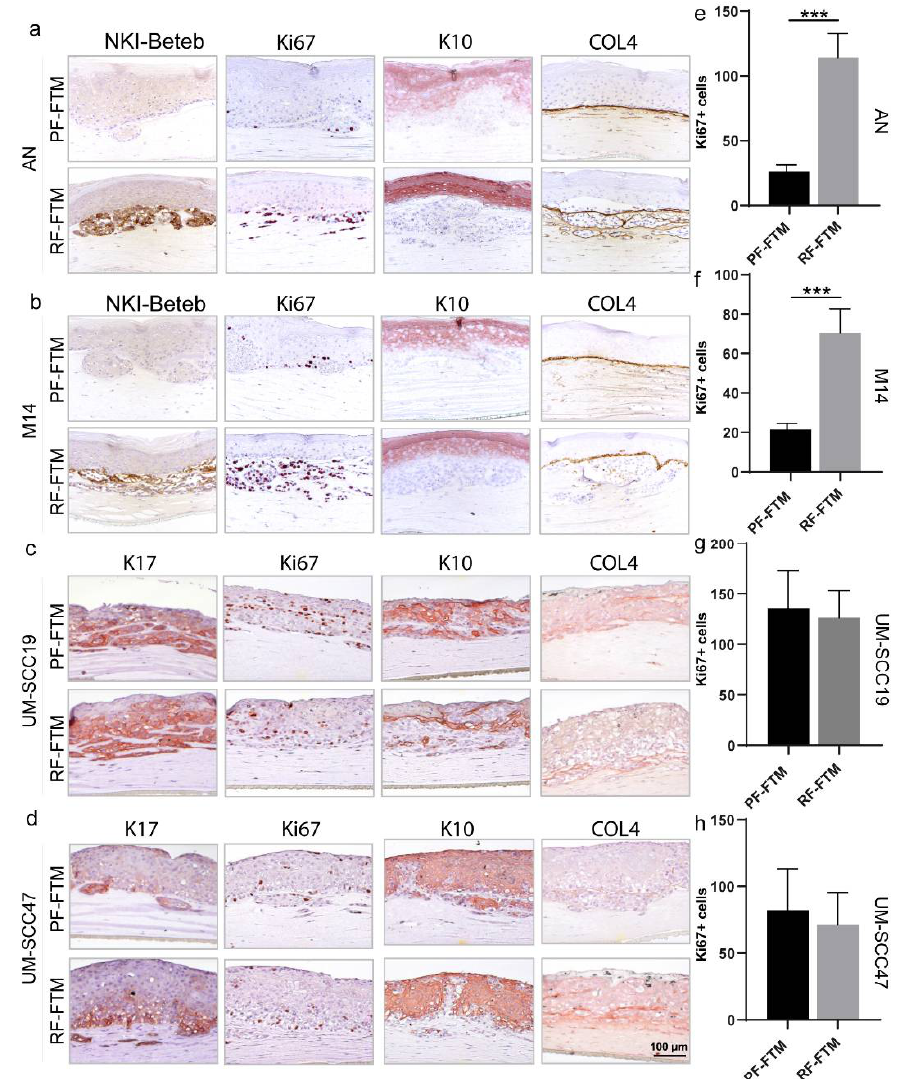
Figure 3. Effect of fibroblast subpopulations on melanoma and HNSCC morphogenesis. By IHC staining, the expression of NKI/Beteb, Ki67, K10 and COL4 were detected in ( a ) AN-FTMs and ( b ) M14-FTMs. The expression of K17, Ki67, K10 and COL4 was detected in ( c ) UM-SCC19-FTMs and ( d ) UM-SCC47-FTMs. The number of absolute Ki67-positive cells in ( e ) AN-FTMs, ( f ) M14-FTMs, ( g ) UM-SCC19-FTMs, and ( h ) UM-SCC47-FTMs was counted. Data was collected from three donors and from three independent experiments and is presented as mean ± standard deviation (SD); *** p < 0.001.